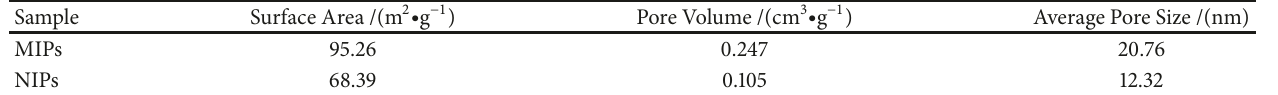
Table 2: Comparison of MIPs and NIPs from nitrogen adsorption-desorption analysis.